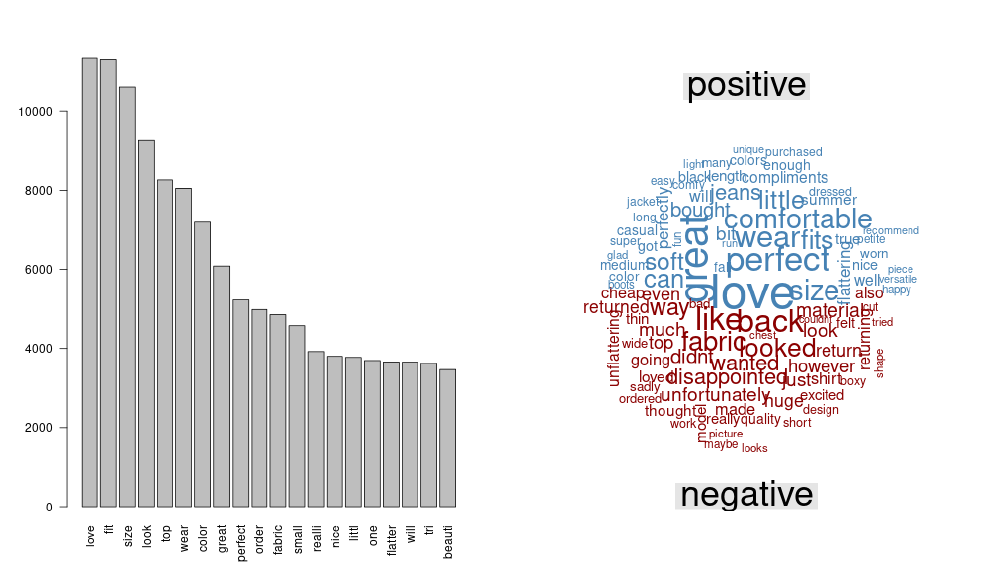
Figure 5. Text summary: the 20 words more frequent (left), and a word cloud of 100 terms colored by the recommended (positive or negative).